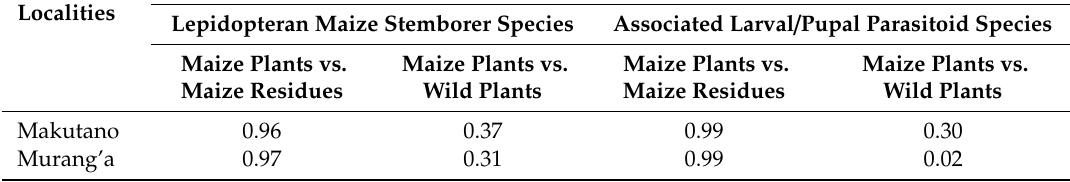
Table 7. The Morista–Horn similarity index between maize plants versus maize residues and between maize plants versus wild plants in the carry-over of lepidopteran maize stemborers and associated larval / pupal parasitoid